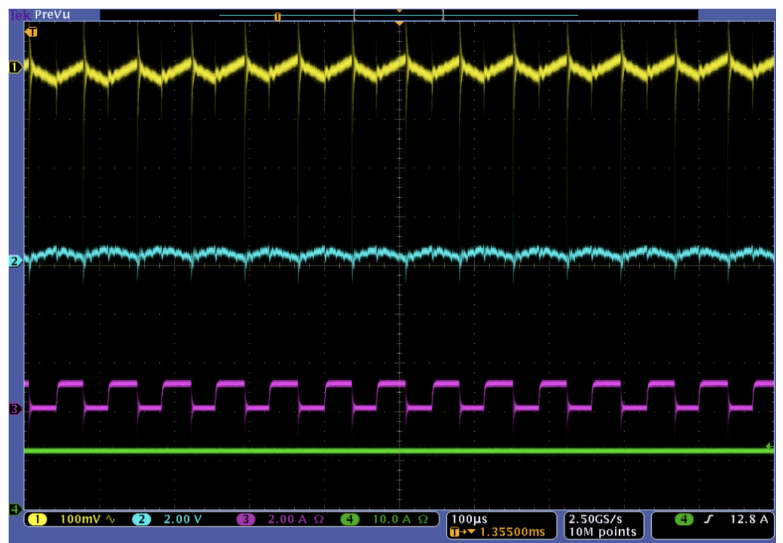
Figure 10. Experimental results (steady-state), ILoad = 12.5 A. Yellow, bus voltage ripple; blue, low- power sections control signal; pink, low-power sections bus current; green, high-power sections bus current.